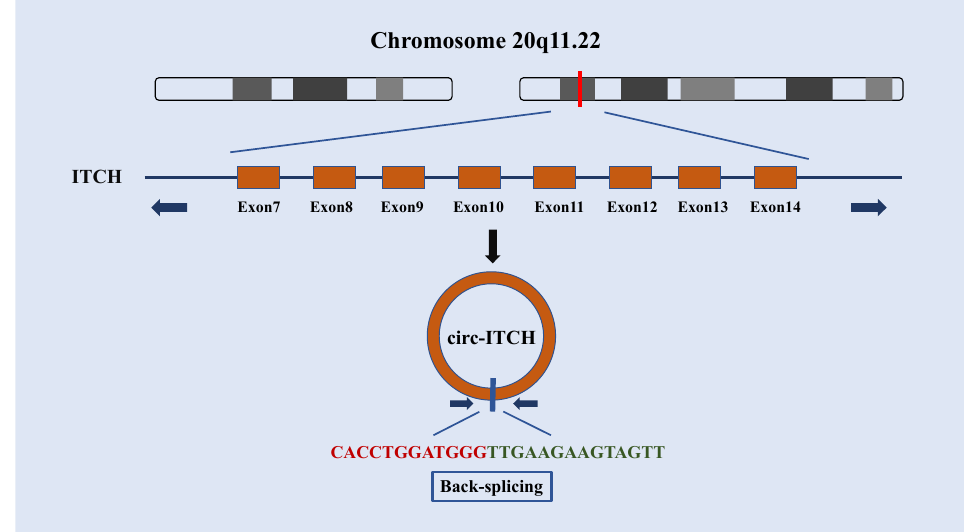
Figure 2. Genomic locus and formation of circ-ITCH. The circ-ITCH located at chromosome 20q11.22. Mature circ-ITCH is derived from exons 7 – 14 of ITCH gene with 873 bp splice length.